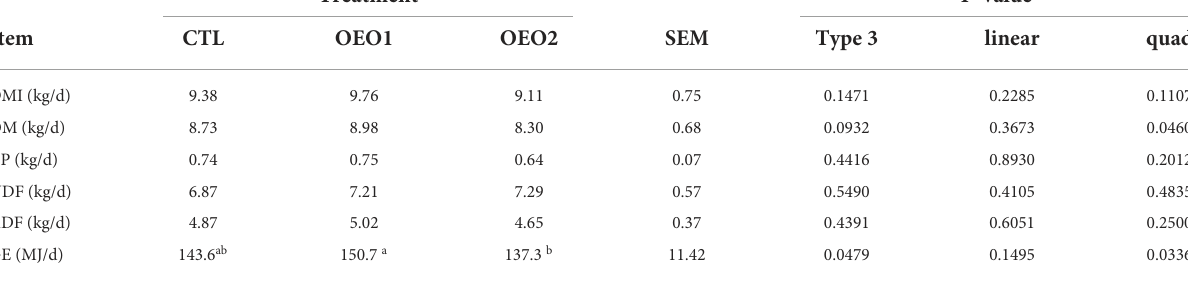
TABLE 6 Effect of orange essential oil (OEO) supplementation on the feed intake of heifers ( n = 6). Treatment P